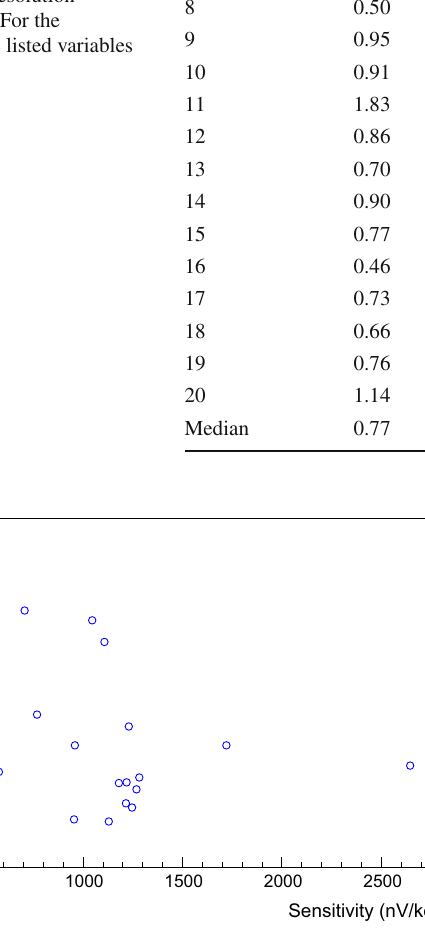
light detectors of the CUPID-Mo experiment. Detectors marked with an asterisk (*) suffer from additional uncertainty due to prominent sinusoidal noise. The